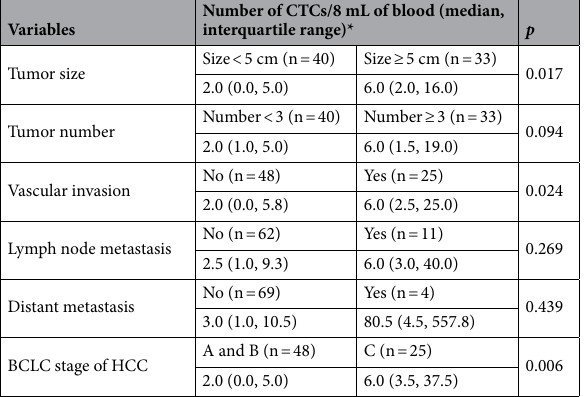
Table 2. Comparison of CTCs number between HCC patients with and without aggressive features. *CTCs numbers were not normally distributed, we used the Mann–Whitney U test to compare the differences in number of CTCs between patients with and without HCC aggressive features.